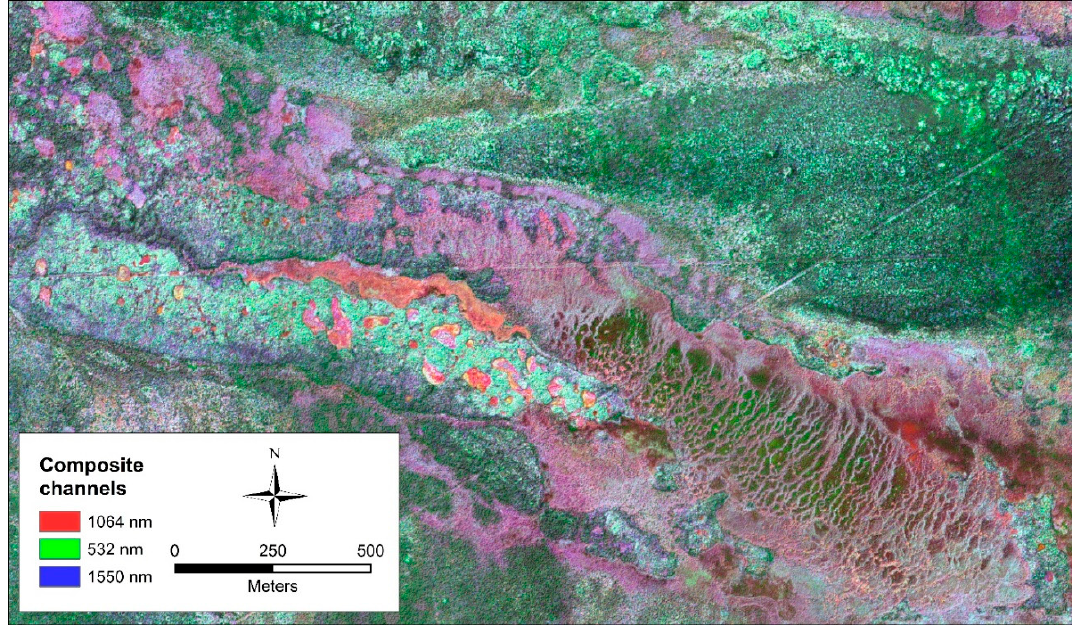
Figure 8. Multispectral lidar colour composite index of laser pulse intensities at 532, 1064, and 1550 nm for a patterned fen complex (red / blue strings, green flarks) with ombrotrophic bogs (red / fuchsia) surrounded by forested uplands (dark green / blue). Wetland complex is located in the Scotty Creek watershed, south of Fort Simpson, Northwest Territories, Canada.